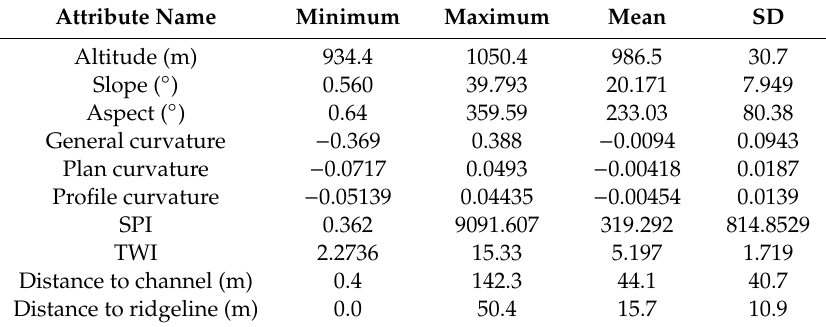
Table 3. Statistics of topographic attributes in the landslides.